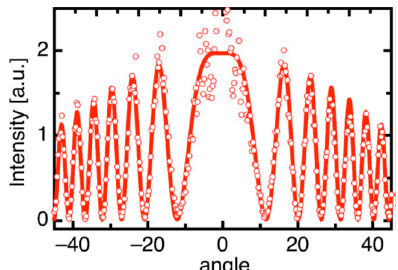
Figure 1. (Color online) Maker-fringe curve obtained by rotating a c plate 4- N , N -dimethylamino-4 ′ - N ′ -methyl-stilbazolium 2,4,6-trimethylbenzenesulfonate (DSTMS) crystal around the dielectric x 1 axis. The impinged fundamental beam at 1.9 μ m as well as the generated second-harmonic light at 0.95 μ m were s polarized [27].